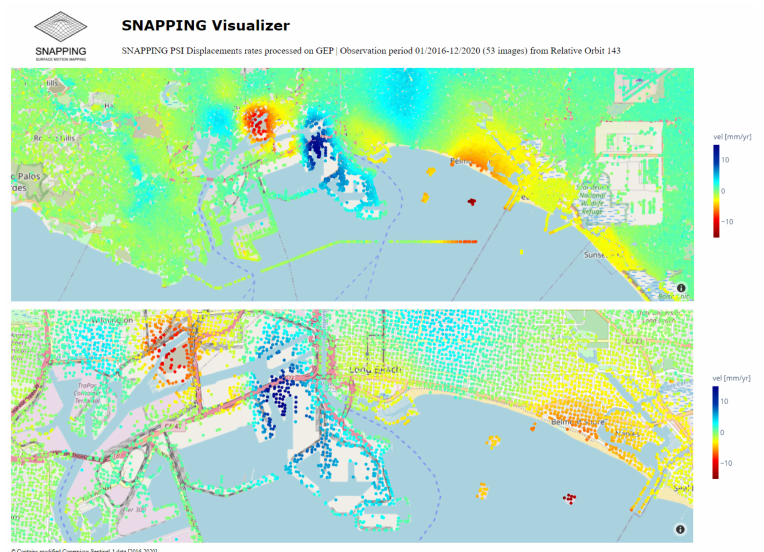
Figure 6. An example of the SNAPPING Visualizer over the southern coast of Los Angeles (USA). SNAP- PING PSI Med processing was based on 53 Sentinel-1 scenes (track 143) acquired from January 2016